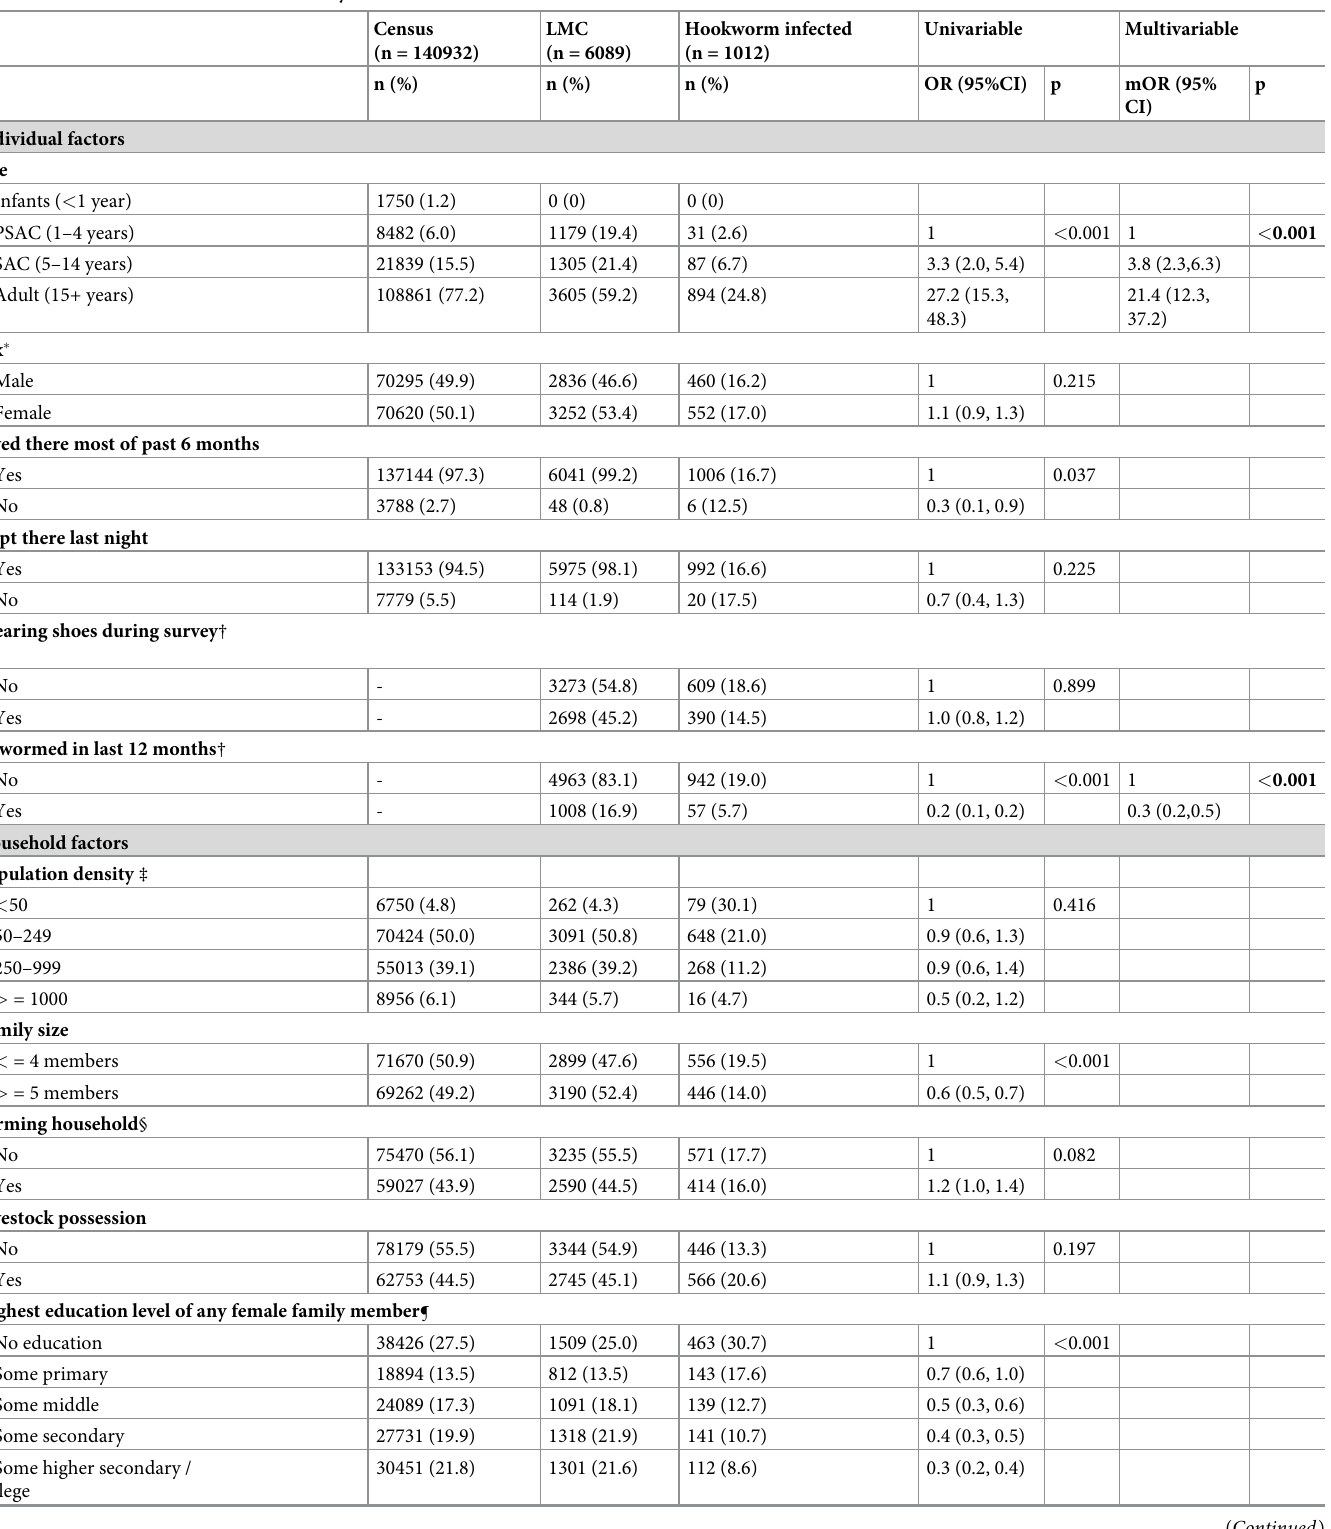
Table 2. Univariable and multivariable analysis of factors associated with hookworm